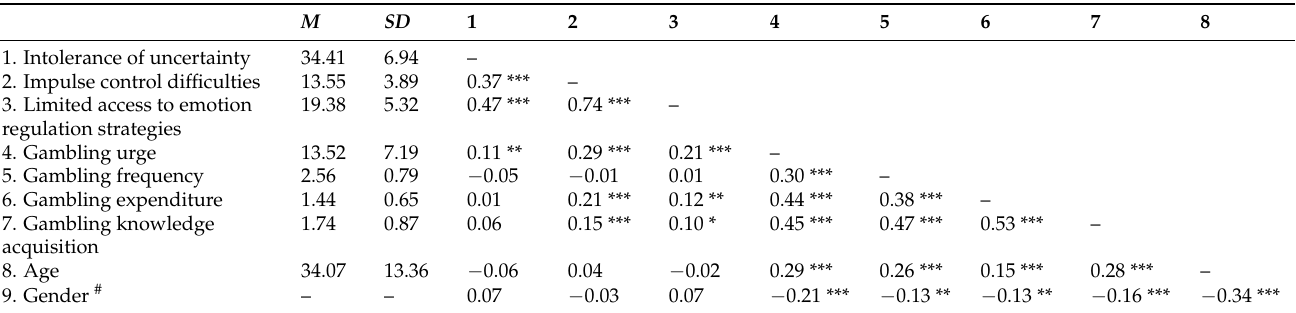
Table 1. Descriptive statistics and inter-correlations of all